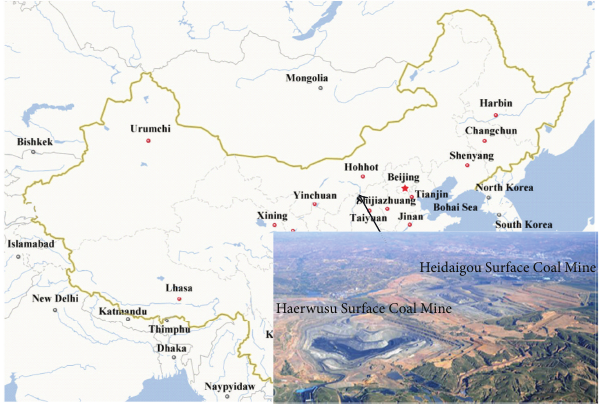
Figure 11: Heidaigou Surface Coal Mine